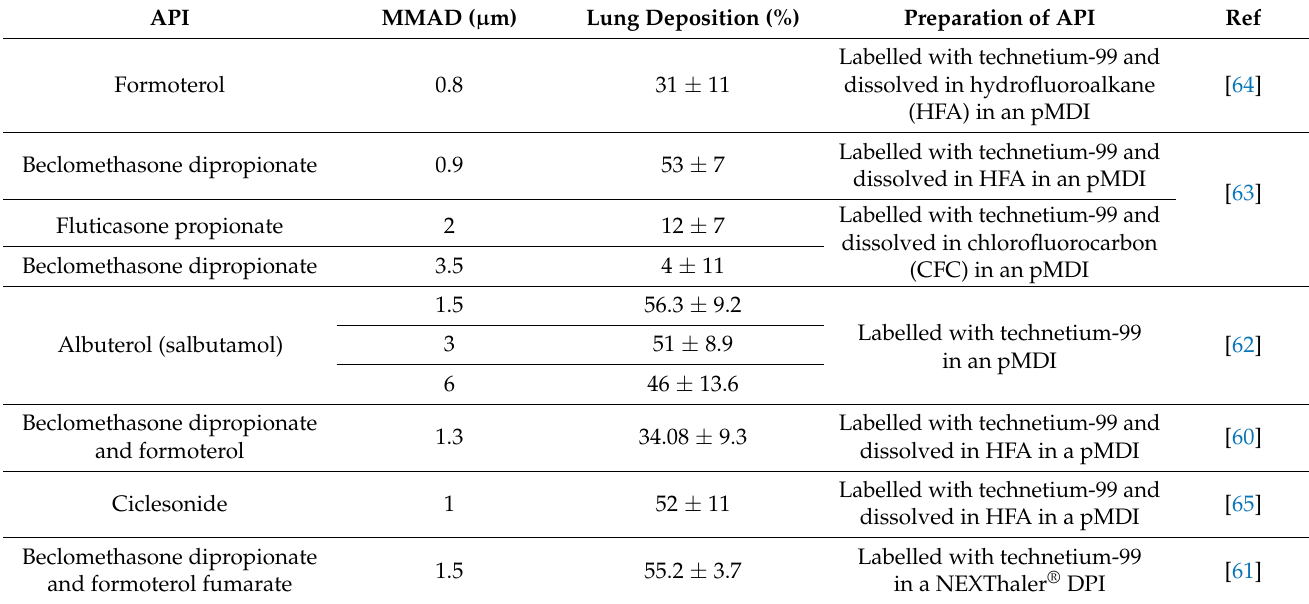
Table 4. MMAD, lung deposition and preparation method of different inhaled